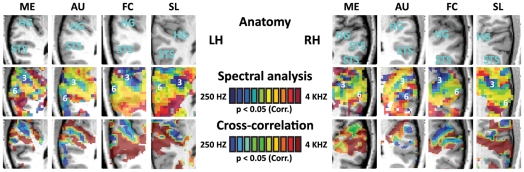
Multiple cochleotopic maps in single subjects.Anatomical structures of the horizontal views of each subject in the magnified area of the auditory cortex, unsmoothed spectral analysis relative frequency preference maps (individual R>0.18, df = 299, p<0.05, corrected for multiple comparisons) and cross-correlation maps (p<0.05, corrected for multiple comparisons) and shown for four different subjects (these and similar maps from additional horizontal slices are presented in Fig. S6). Overlaid on the spectral analysis maps are numbers (3, 6) representing the low-frequency peaks corresponding to those presented in the group results. Point 3 corresponds to the border between A1 and R and point 6 represents the low frequency band on the lateral STG possibly corresponding to a homologue of area CL of the belt. Single subject maps show cochleotopic maps that extend beyond the auditory core to the superior temporal gyrus and superior temporal sulcus. HG - Heschl's gyrus, STS – Superior temporal sulcus.